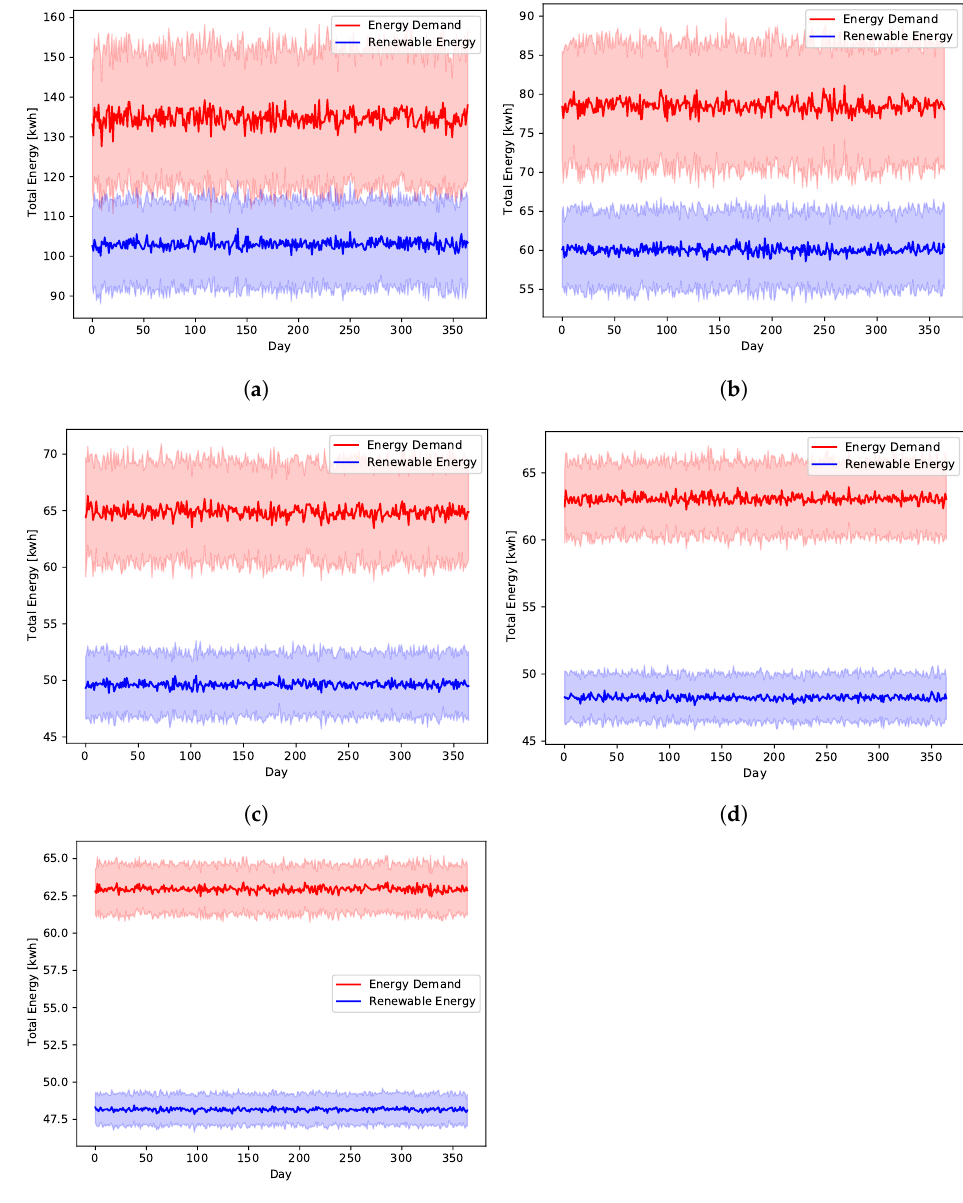
Figure 7. The simulated E res and L ( t ) with different global uncertainty levels. ( a ) U 10 , ( b ) U 25 , ( c ) U 50 , ( d ) U 75 , ( e ) U 95